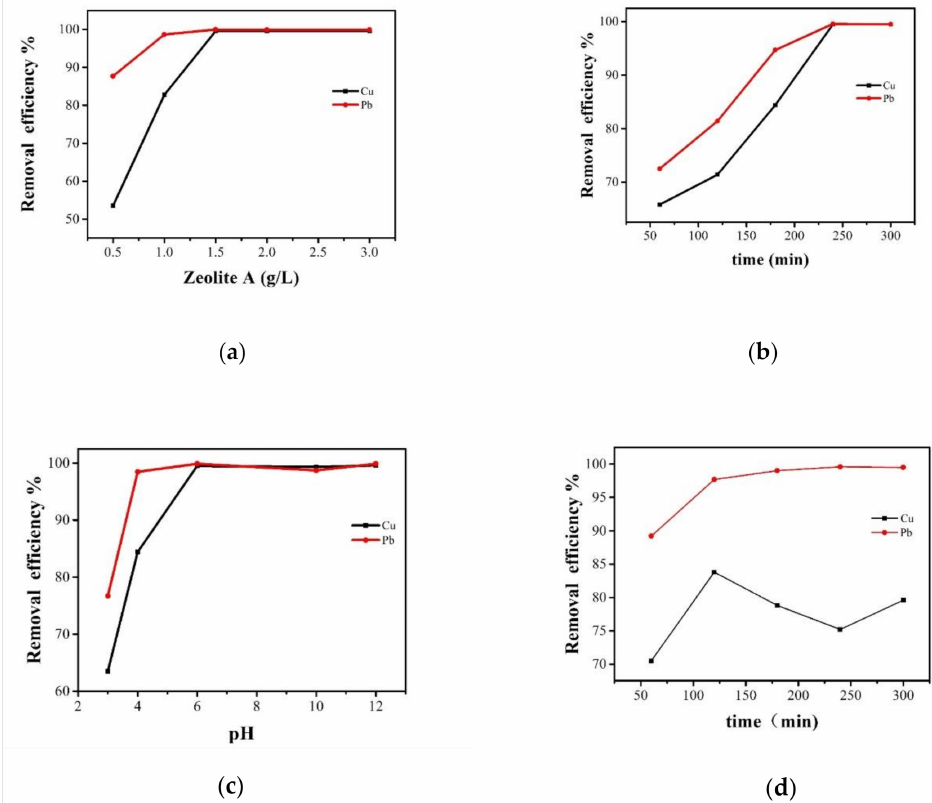
Figure 11. E ff ects of di ff erent conditions on the removal rate of heavy metal ions. ( a – d ) are the